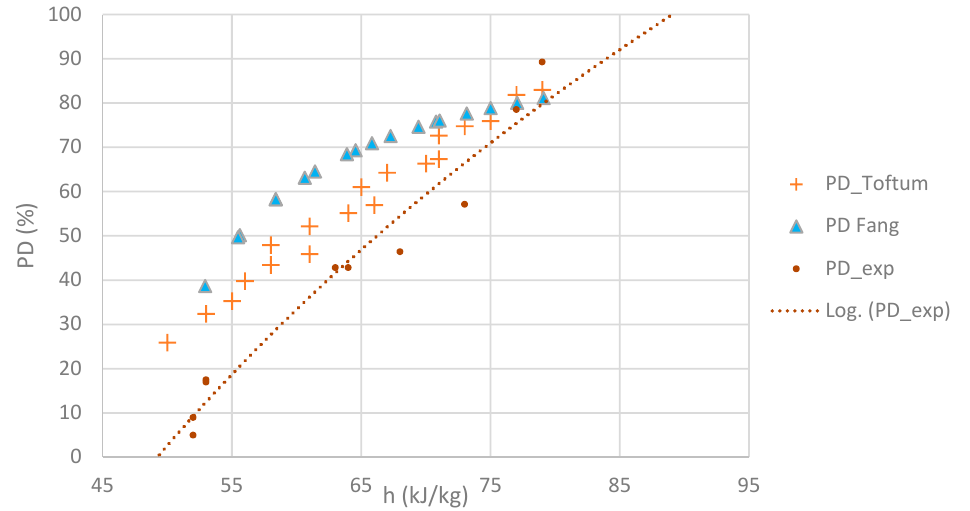
Figure 9. Comparison of experimental results of percentage dissatisfied in function of the air enthalpy (log. PD-exp ) to the research results obtained by Fang ( PD_Fang ) [7] and Toftum ( PD_Toftum ) [15].